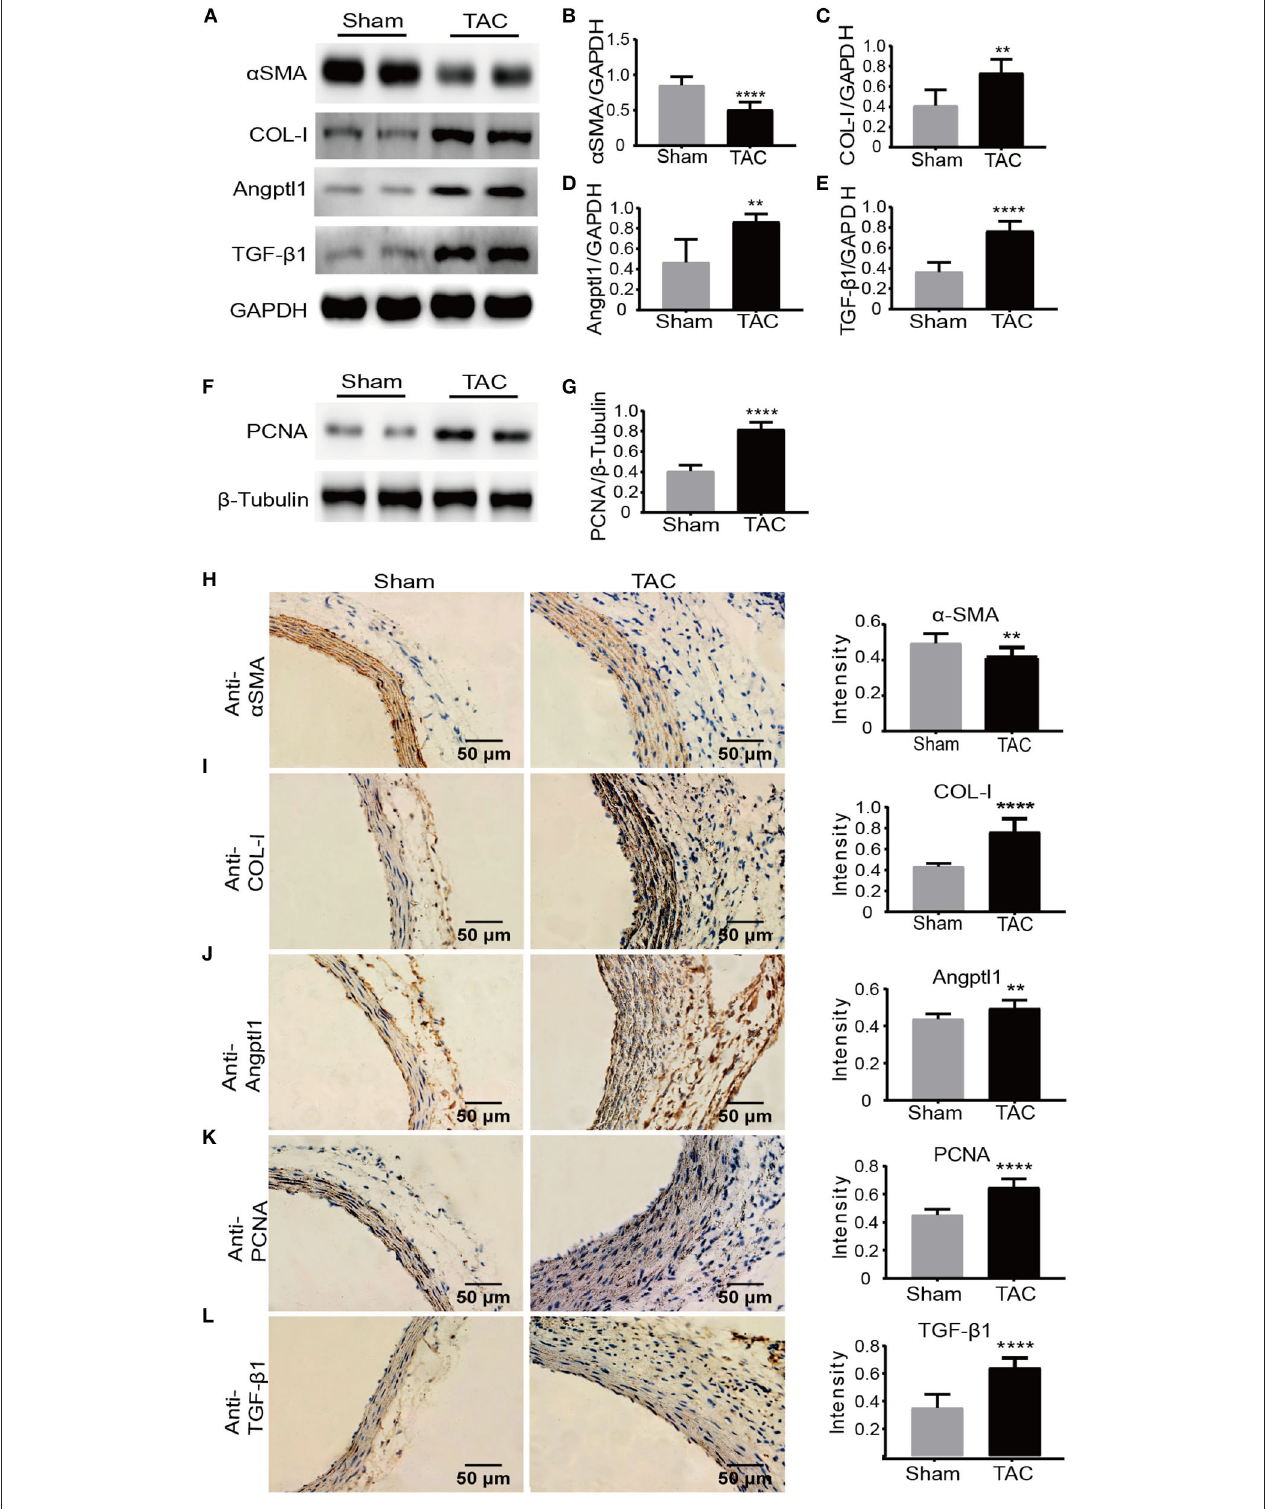
FIGURE 5 | Protein level validation of DEGs revealed by RNA-seq. (A–G) Western blot analysis of α -SMA, COL-I, Angptl1, TGF- β 1, and PCNA in the TAC and sham groups. GAPDH and β -Tubulin were used as endogenous loading controls. Lysates were prepared from ascending aortas of sham-operated or TAC mice, n = 5 per group. The experiments were repeated 3 times independently; (H–L) Immunohistochemistry and quantification analysis of α -SMA, COL-I, Angptl1, TGF- β 1, and PCNA in ascending aortas derived from TAC or sham controlled mice. n = 6 per group. Original magnification: × 400. Scale bars: 50 µ m. ** P < 0.01, **** P < 0.0001.